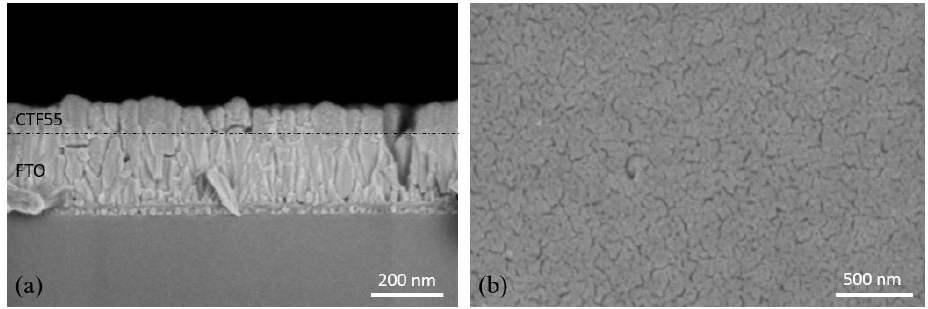
Figure 4. SEM images of ( a ) cross-section and ( b ) top view thin CTF55 film by pulsed laser deposition close to 100 nm in thickness on a FTO layer of 200 nm.